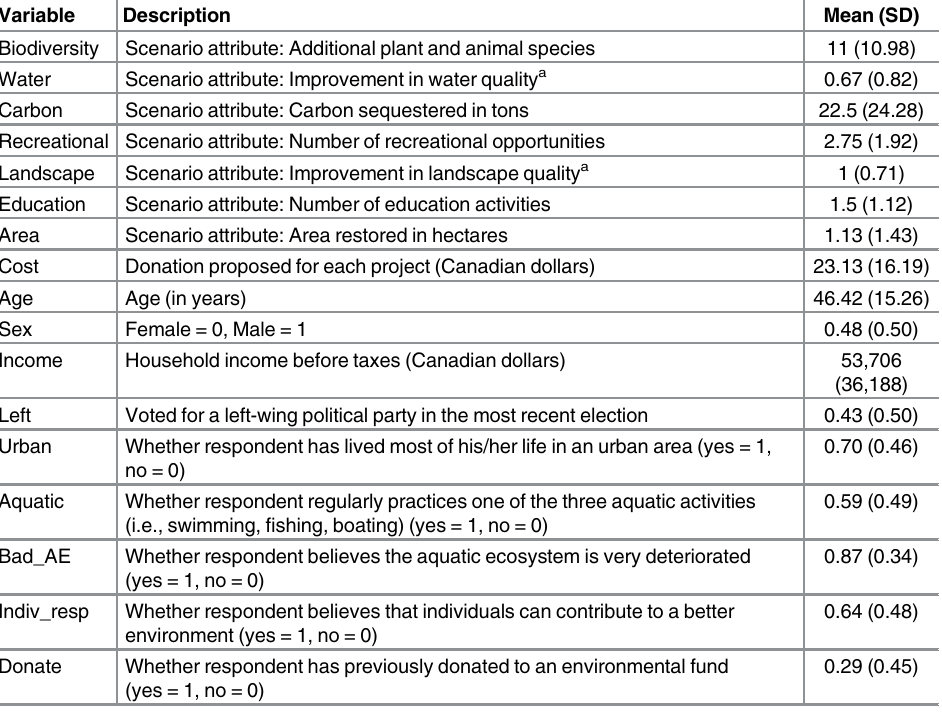
Table 2. Descriptive statistics of variables used in the